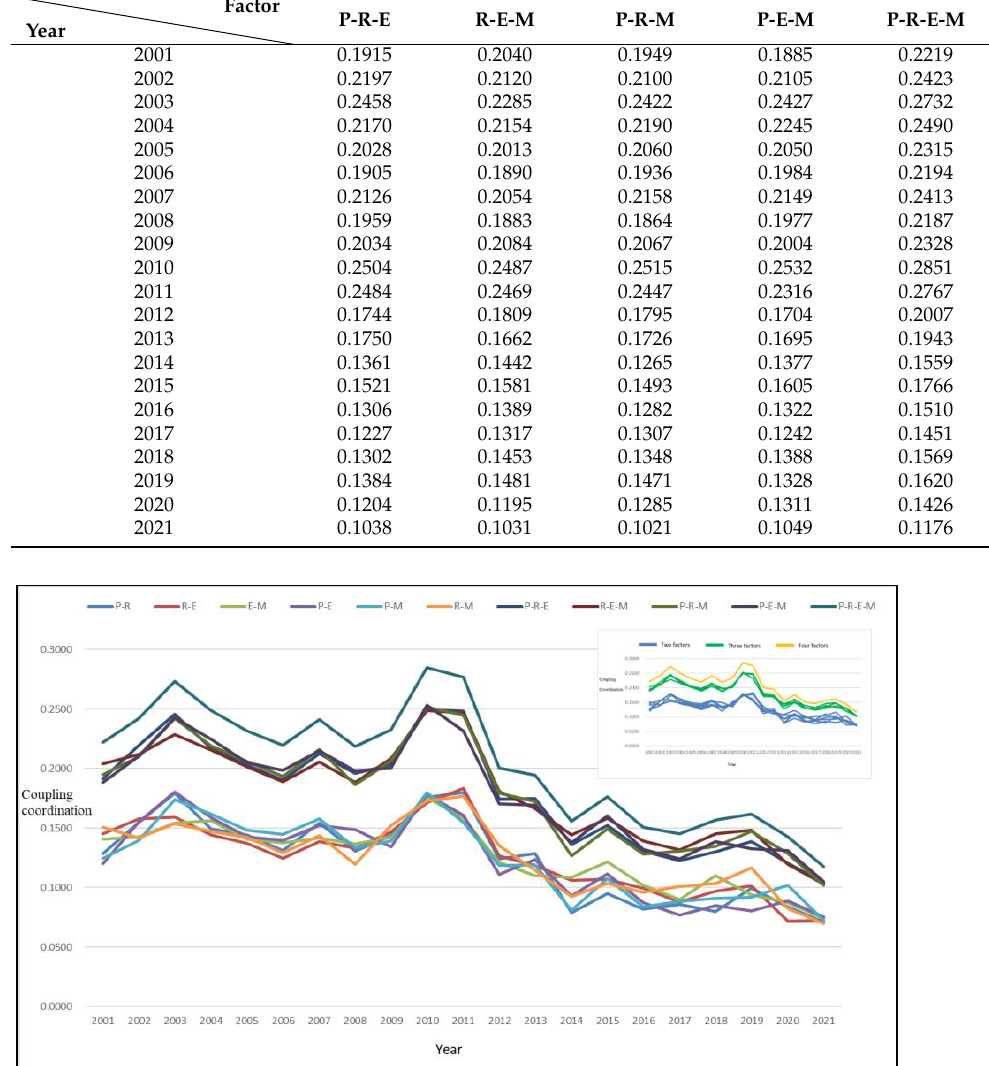
Table 8. The coupling coordination degree K j of three risk factors and four risk factors.